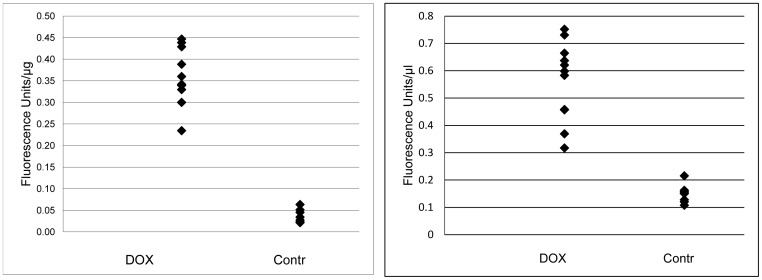
DOX concentration in hearts (A) and blood (B) of rats 48 hours following administration of 12 mg/kg DOX.
P<0.01.